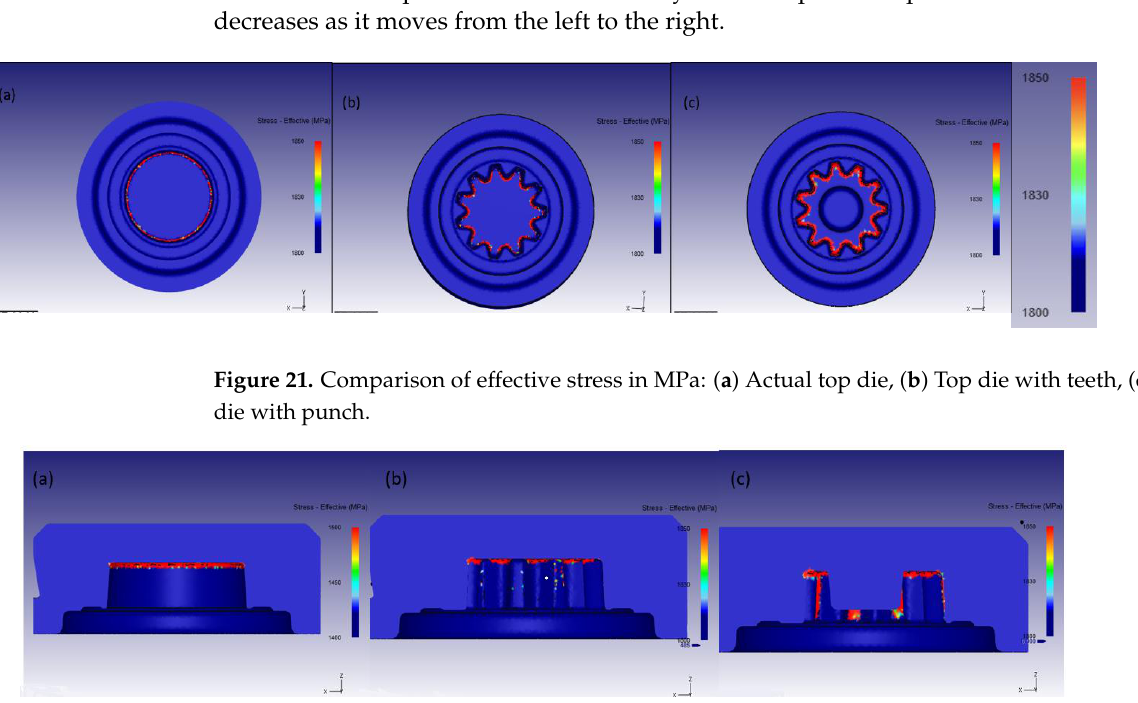
Figure 22. Comparison of effective stress in MPa (with lateral view): ( a ) Actual top die, ( b ) Top die with teeth, ( c ) Top die with punch.